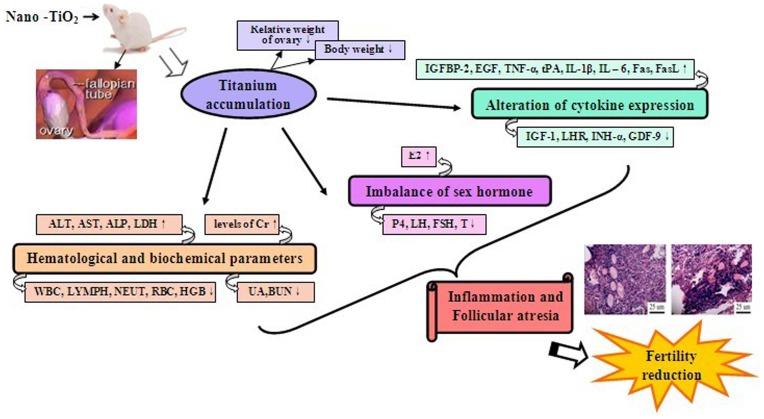
A schematic showing possible mechanisms of nano-TiO2 induced follicular atresia in mouse ovary.